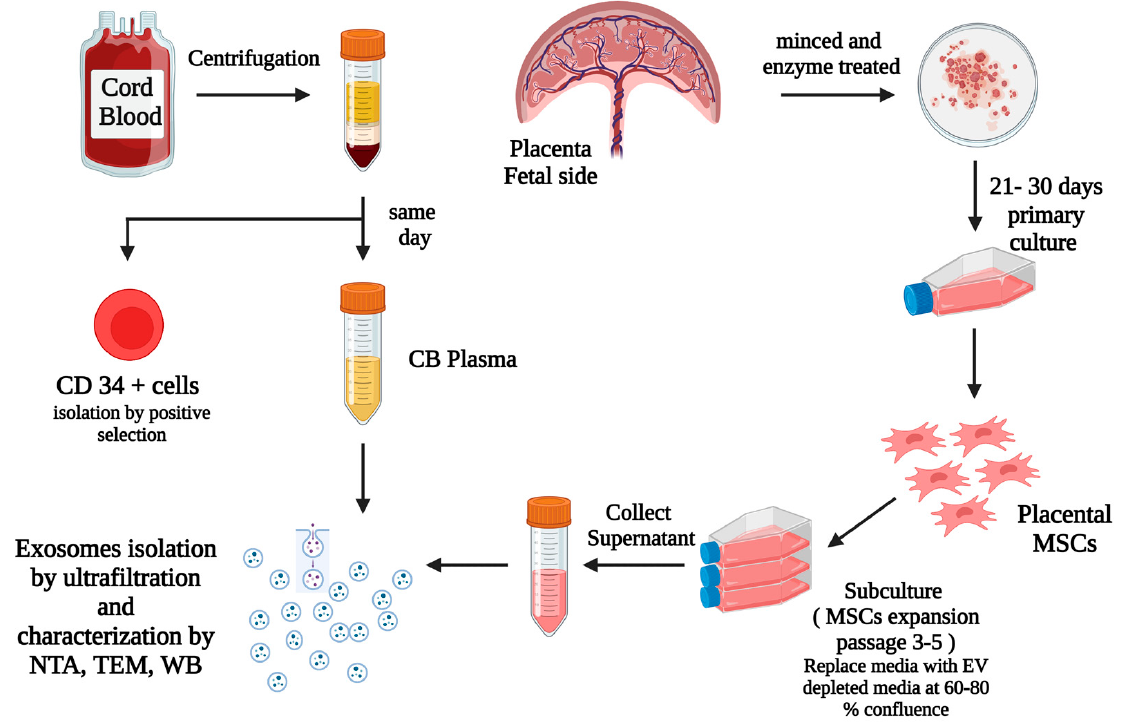
Figure 1. This diagram summarizes our methods and the steps for the isolation of CD34 + cells via positive selection from UCB, isolation, processing, and culture of placental tissues from the fetal side, isolation of primary MSCs (passage 0), expansion of MSCs via subculture from primary MSCs to passage 3–5, replacement of the culture media with EV depleted media when the expanded cells were at 60–80% confluence, then collection of the MSCs culture supernatant after 48 h and exosomes isolation from CBP and MSCs culture supernatants. Created with